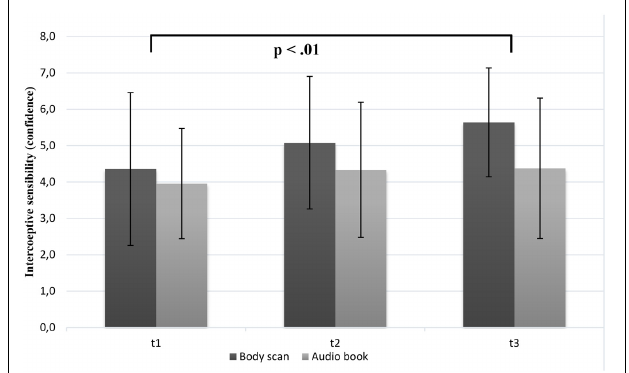
FIGURE 2 | Mean confidence ratings (IS) as a function of group (BS vs. audio book group) and time (note: significant group differences at all time points are not marked here).